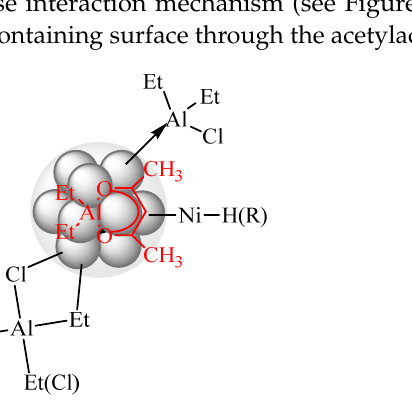
Figure 1. Model of the nanosized particles formed by interaction of Ni(acac) 2 and DEAC or EASC (Al/Ni = 50).